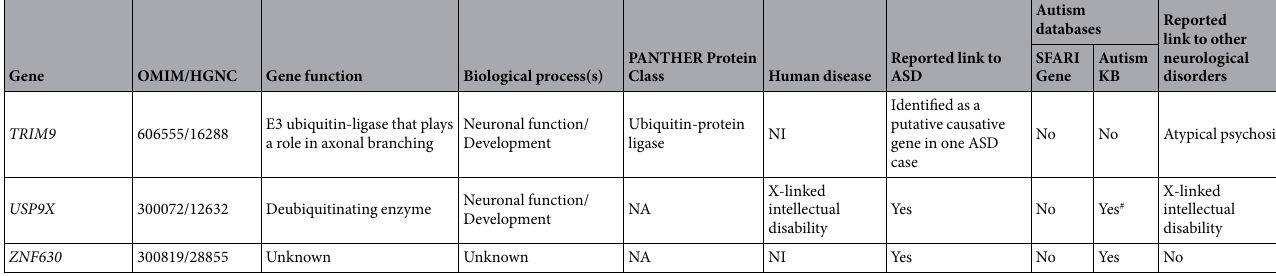
Table 1. Summary of the genes with confirmed rare variants detected in this study. * Nonsynonymous variant(s) were reported. # Synonymous variant(s) were reported. Schizophrenia: SZ. Intellectual disability: ID. Fragile-X: FX. NI: Not identified. NA: Not available. For more details refer to supplementary